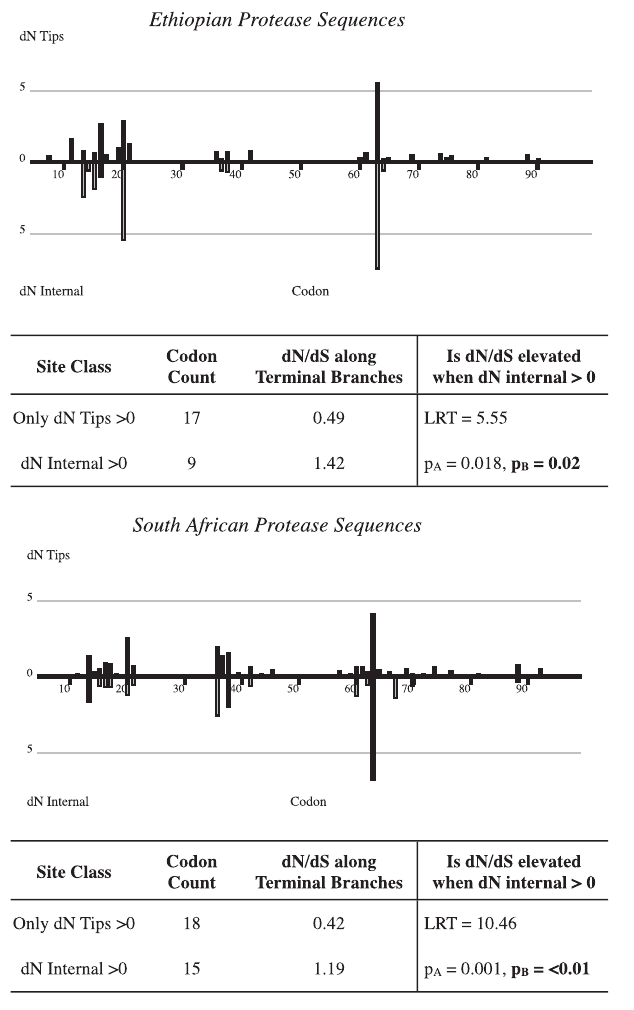
Figure 2. Patterns of Population and Individual Level Nonsynonymous Evolution in the Two RT Samples MLEs of nonsynonymous substitution rates along internal ( dN Internal) and terminal ( dN Tips) branches were derived using the IFEL method. dN/ dS estimates and p -values in the tables were obtained with the Population Level Adaptation test. p A and p B denote, respectively, the asymptotic and parametric bootstrap significance levels for the like- lihood ratio test. DOI: